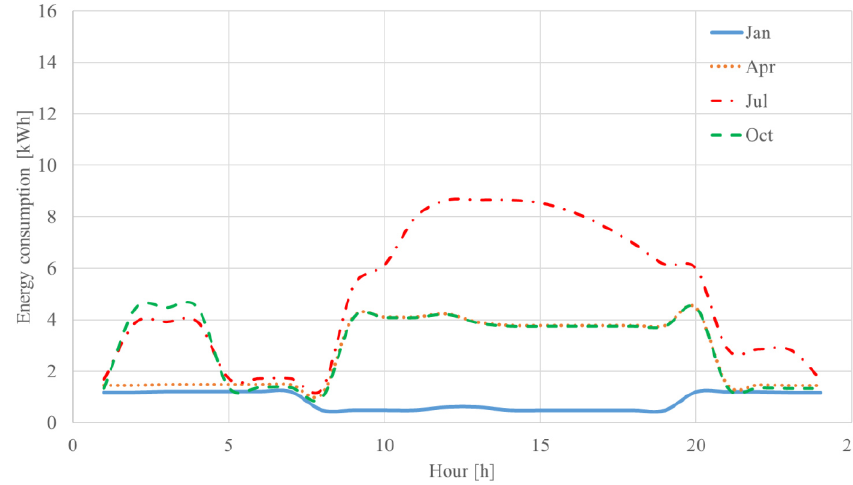
Figure 1. Daily electrical energy consumption for greenhouse without heat pump.